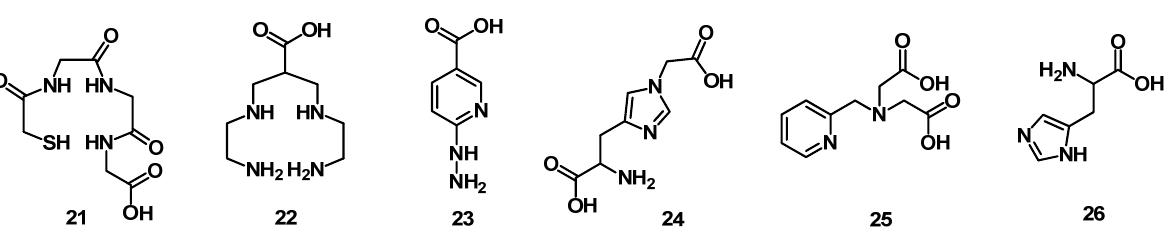
Figure 5. Chemical structure of chelators for the labeling of peptides with 99m